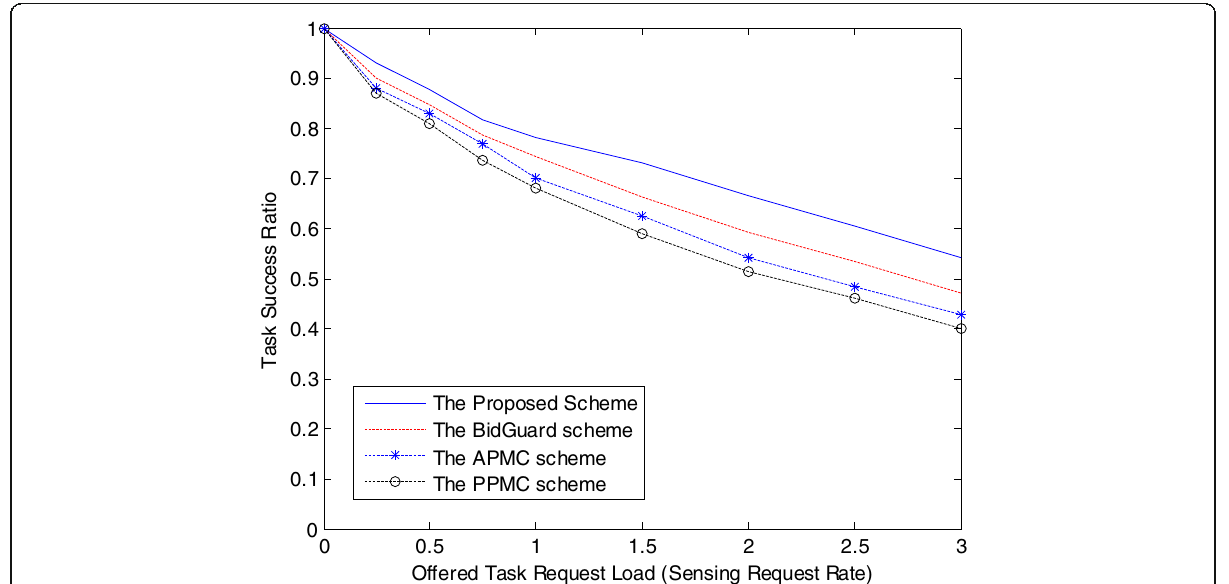
Fig. 1 MC task success ratio. The task success ratio is defined as the ratio of the total number of sensing tasks applications which have been generated by the MCS to the number of task applications which are successfully